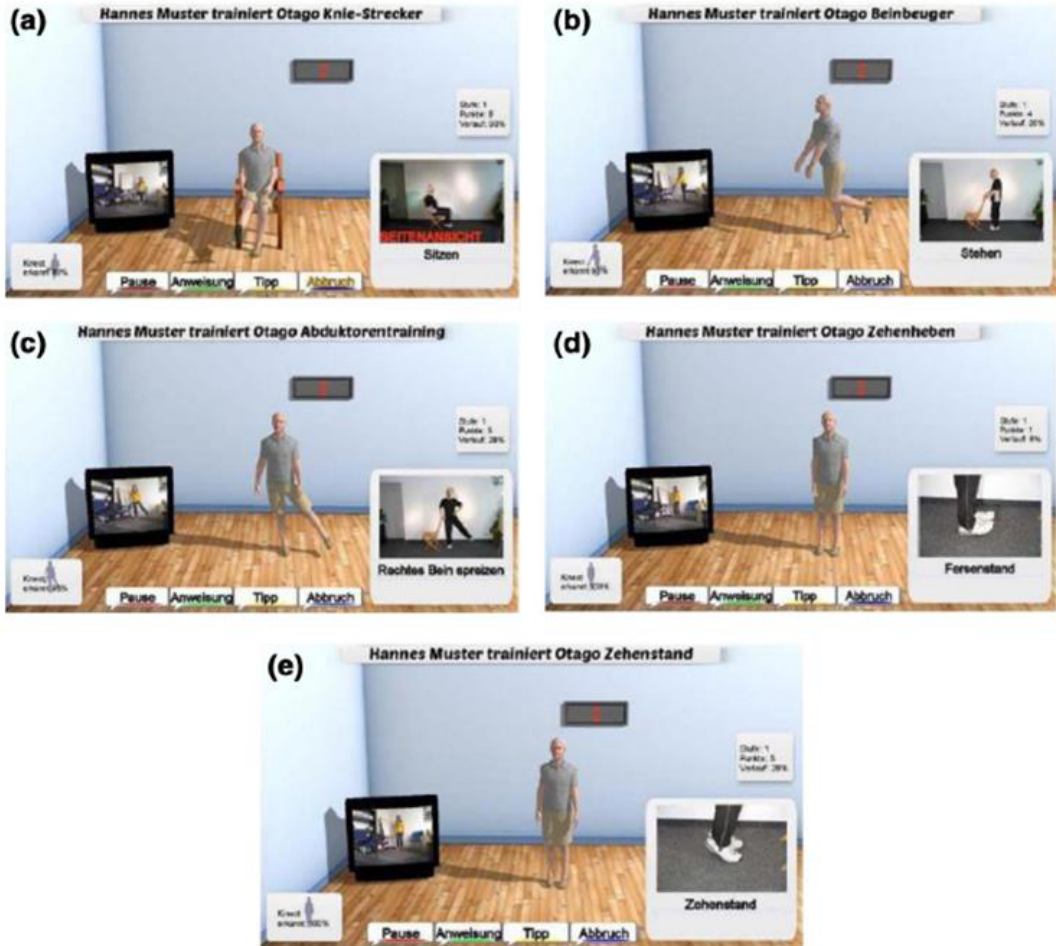
Figure 5. The different Otago exercises integrated into the iStoppFalls ICT-based system. (Permission granted by the Dr Rainer Wieching—PI, [57]). ( a ) Knee extension, ( b ) knee flexion, ( c ) leg abduction, ( d ) toe raises, ( e ) calf raises. There is a demonstration via the icon on the bottom right hand side of the screen. On the right side of the screen, the users are able to see themselves on the television screen. The four buttons at the bottom of the screen (pause, instructions, tips, and abort) can be selected by the users to execute the command.